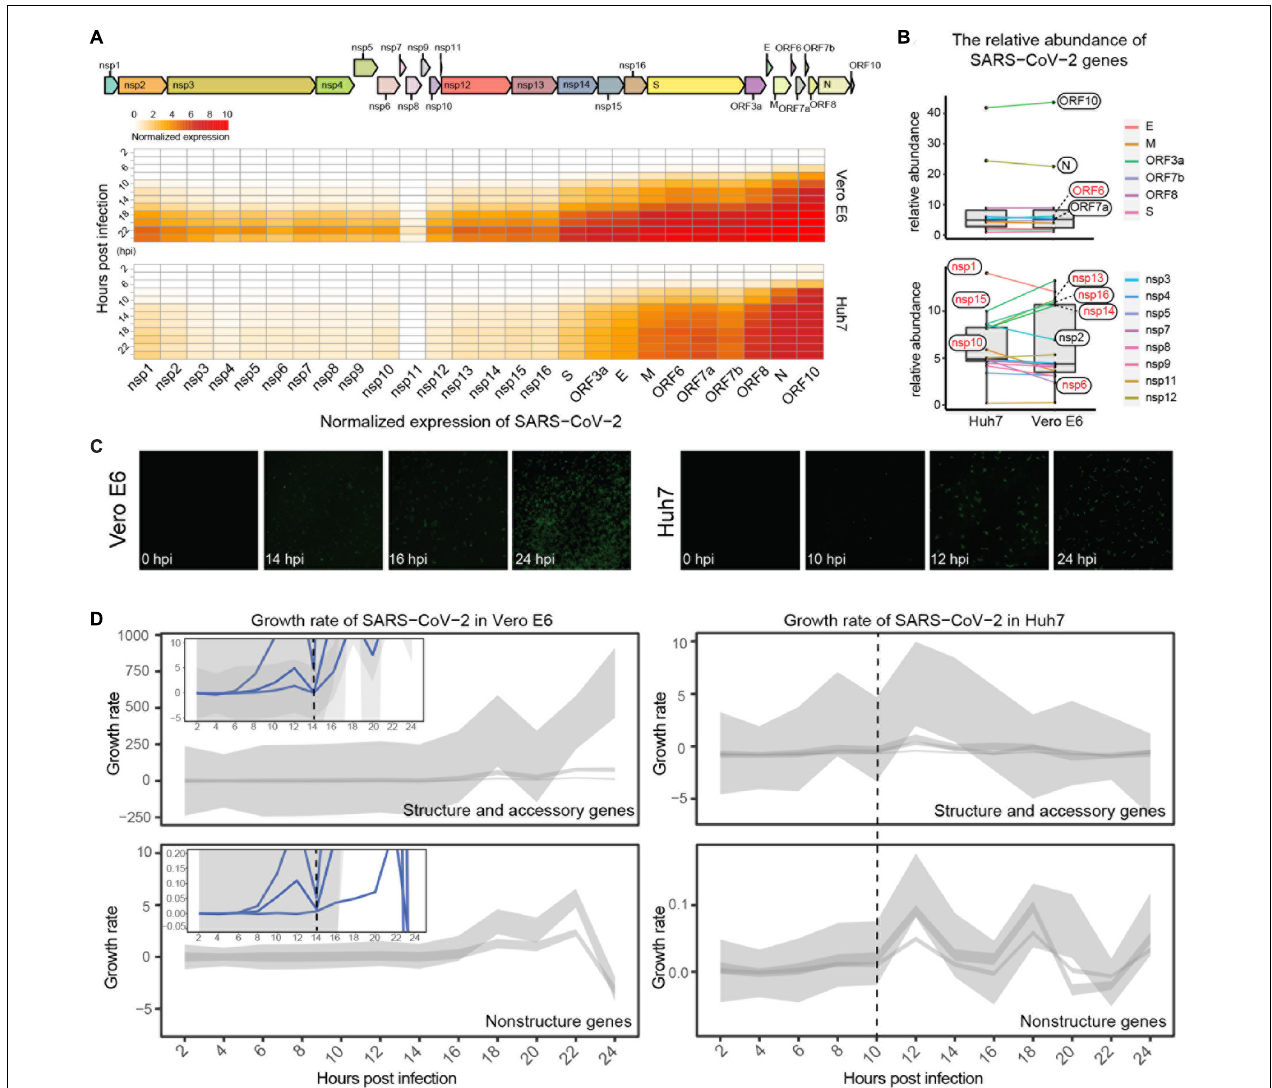
FIGURE 1 | Expression dynamics of SARS-CoV-2 viral genes. (A) Genomic structure of SARS-CoV-2 and expression trends of its genes in Vero E6 and Huh7. Heatmap showing dynamics of normalized viral gene expression (ranging from 0 to 10), with white and red representing no and high expression, respectively, and horizontal and vertical axes representing each gene of SARS-CoV-2 and time of infection, respectively. (B) Comparison of relative abundance of each viral gene in different cells. Mean value of each viral gene at 0–24 hpi was calculated, and its percentage of total expression was determined as relative abundance; genes with inconsistent trends are marked in red. (C) Immunofluorescence assay of nucleocapsid protein of SARS-CoV-2. (D) Growth pattern of viral genes in Vero E6 and Huh7 cells. Expression heatmaps consist of normalized counts, which show accumulation of viral load, and growth curves represent transcriptional activity of viral genes at different moments. Due to large variation in y-axis range, structural genes are shown separately from non-structural genes, and small views of same y-axis range as Huh7 are appended to Vero